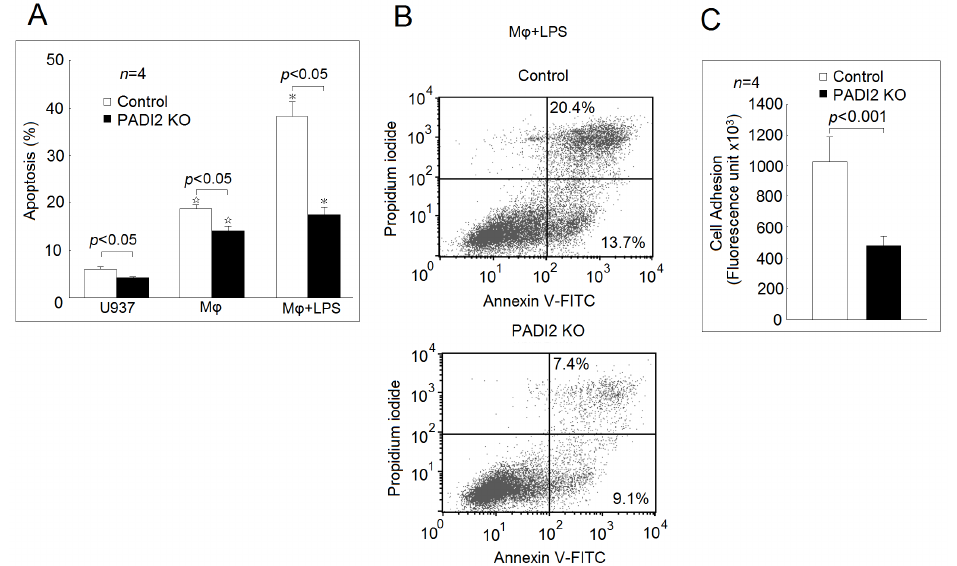
Figure 3. Effects of PADI2 knockout on macrophages apoptosis and adhesion. ( A ) The apoptosis rates of the U937 cells, the di ff erentiated macrophages, and the macrophages stimulated with LPS for 24